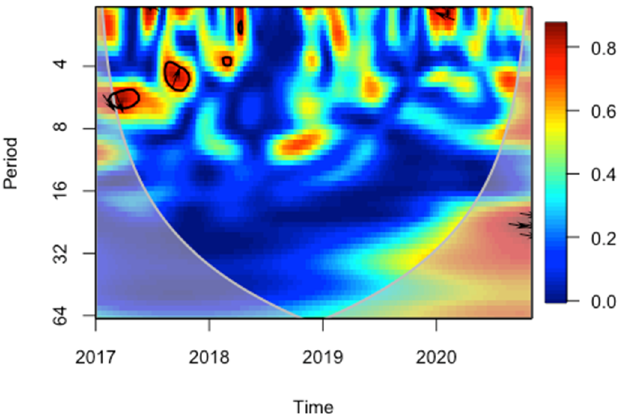
Panel B . Wavelet coherence: CryptoPunk attention and Bitcoin returns